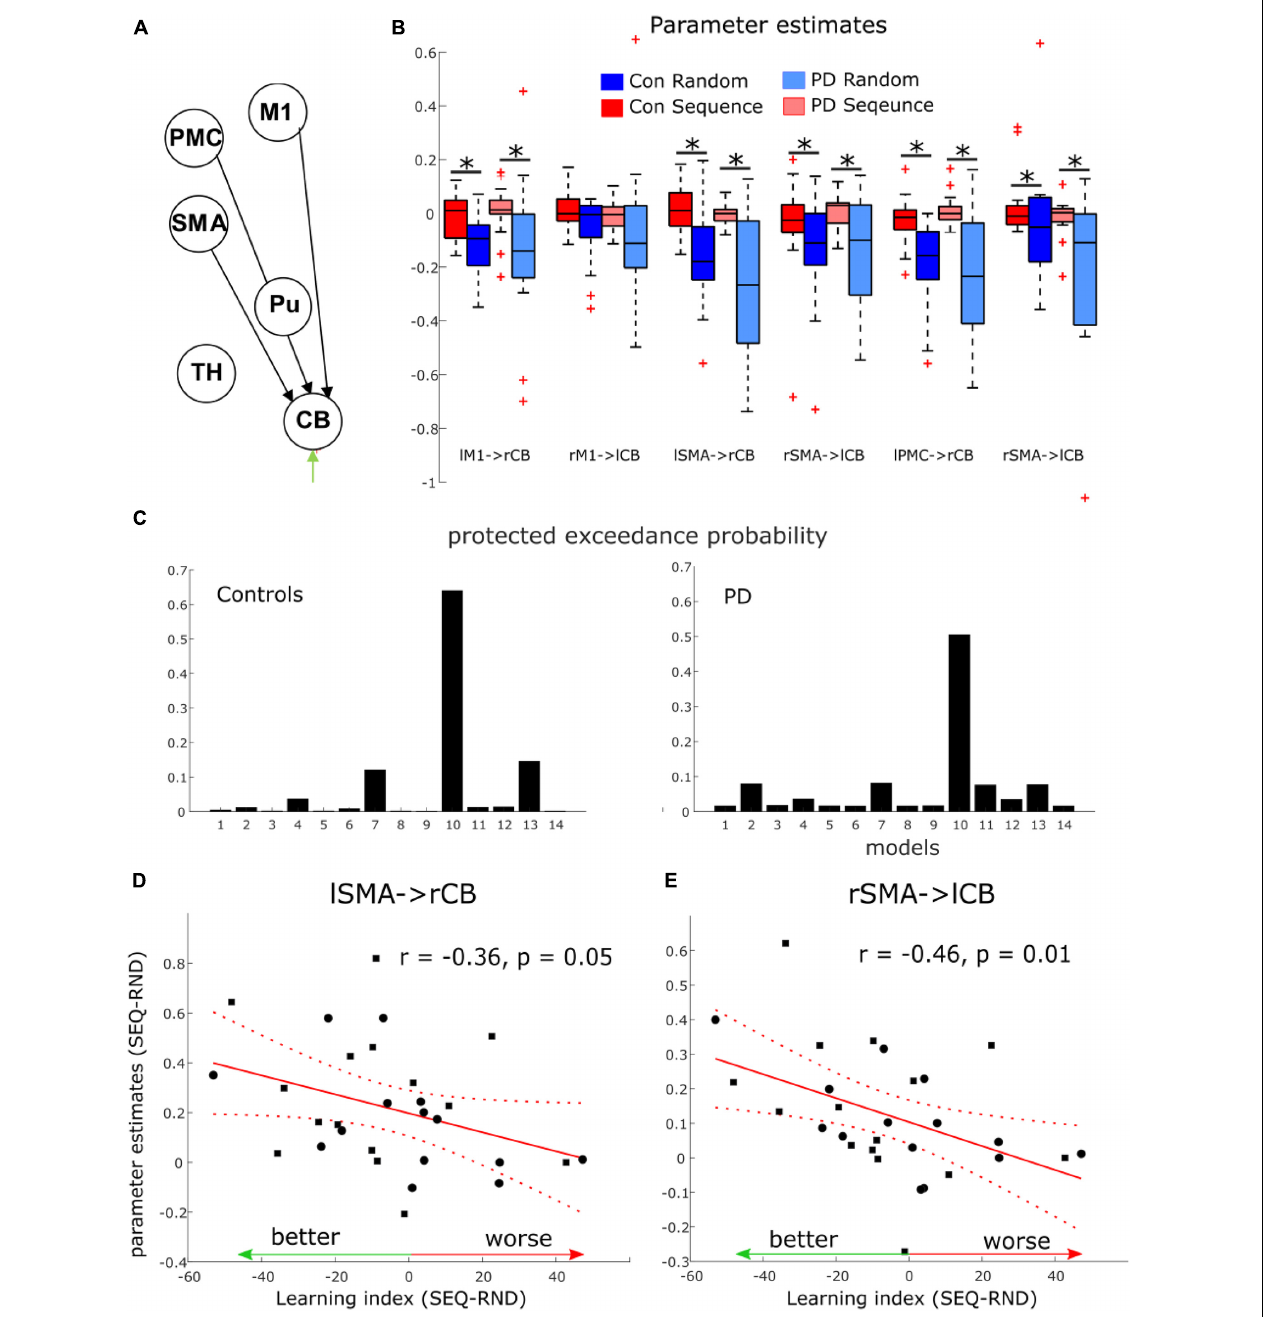
FIGURE 4 | Dynamic causal modeling results of the cortico-striatal-thalamo-cerebellar network. (A) Winning model in both groups. Note that the model had 12 nodes in both hemispheres. Here only 6 nodes in left cerebrum and right cerebellum are depicted. M1, primary motor cortex; PMC, premotor cortex; SMA, supplementary motor area; Pu, putamen; TH, thalamus; CB, cerebellum. (B) Boxplots for parameter estimates in the winning model (A) for both groups (PD, controls) and conditions (Sequence, Random). Significant differences are marked with a star. (C) Protected exceedance probability in healthy controls and PD showing model 10 (CB pathway 3) was favorable over the other models ( Figure 2 ). (D,E) Correlation between condition differences in modulation of SMA– > CB connection and learning index.